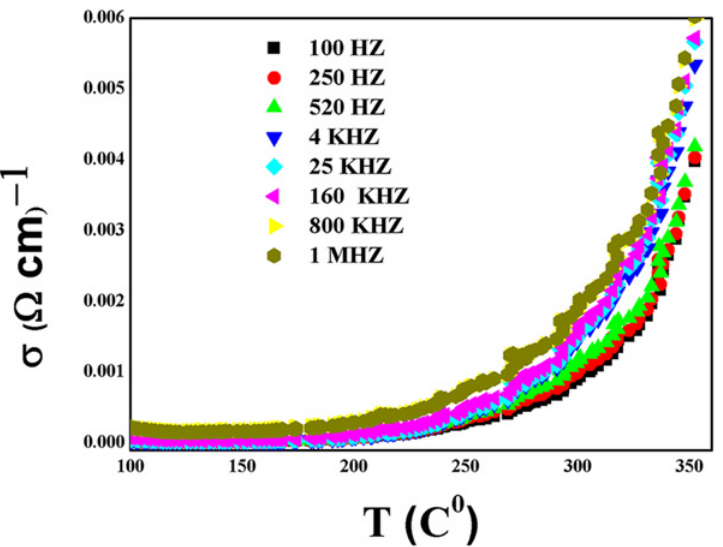
Fig 8. The variation of ac conductivity of CeO 2 nanopartciles with temperature at different frequency.